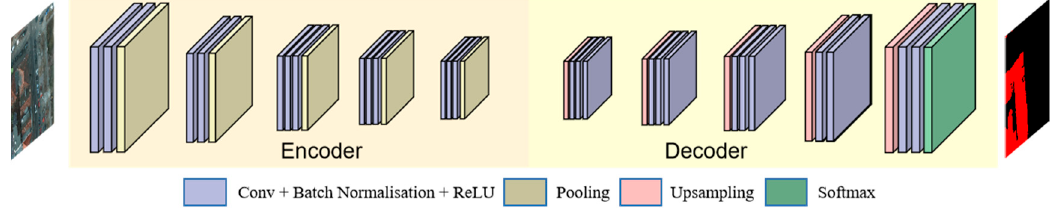
Figure 1. SegNet architecture for building extraction of EO data [23,33].